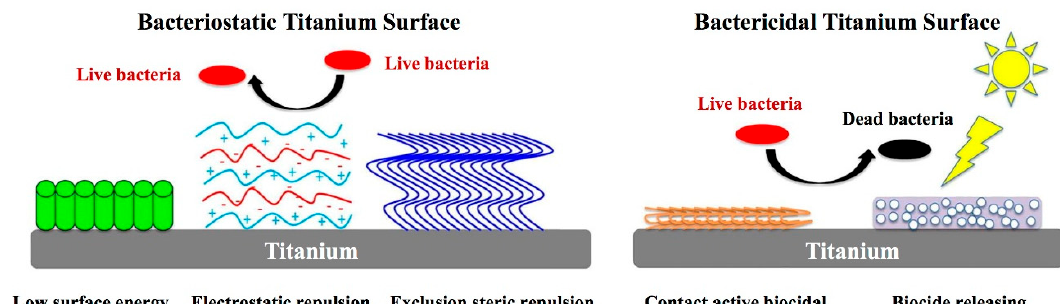
Figure 7. Various examples of antimicrobial surfaces according to the mechanism of action: bacteriostatic or bactericidal surfaces.The prevention of biofilm formation by antimicrobial coatings is the best way to prevent primary adhesion or killing approaching bacteria [112]. Copyright 2019 Acta Materialia Inc.